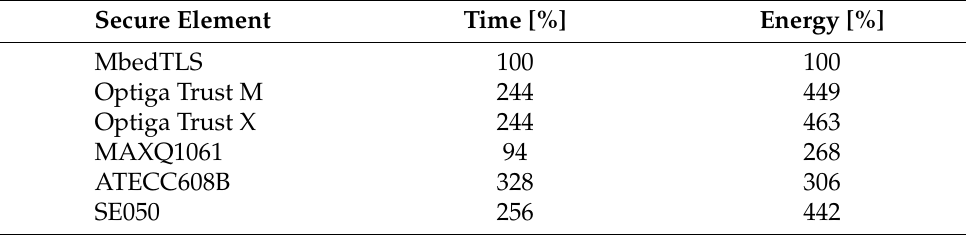
Figure 7. Time and energy measured for getting 32 bytes of random data relative to the reference implementation. (median of values, rounded to the nearest percent, n = 100). Table 1. Table of values for Figure